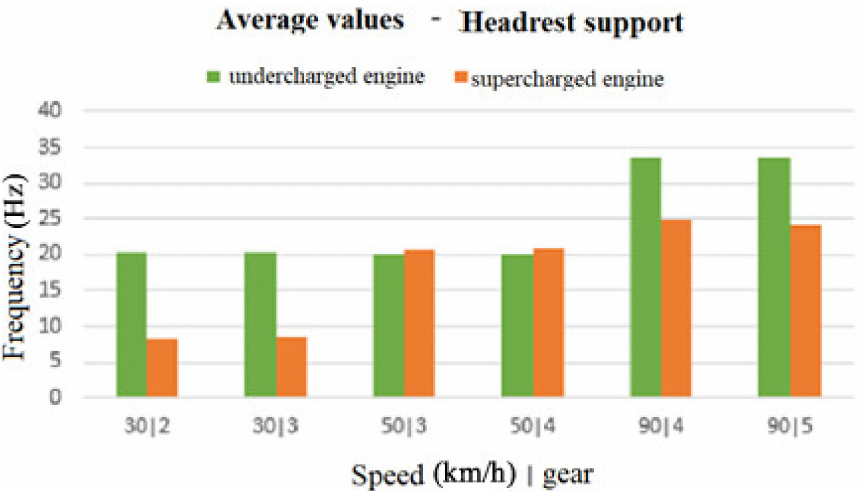
Figure 9. Comparison of average values of dominant harmonic vibrations measured at the seat (headrest mounting) for the older (green) and the newer models